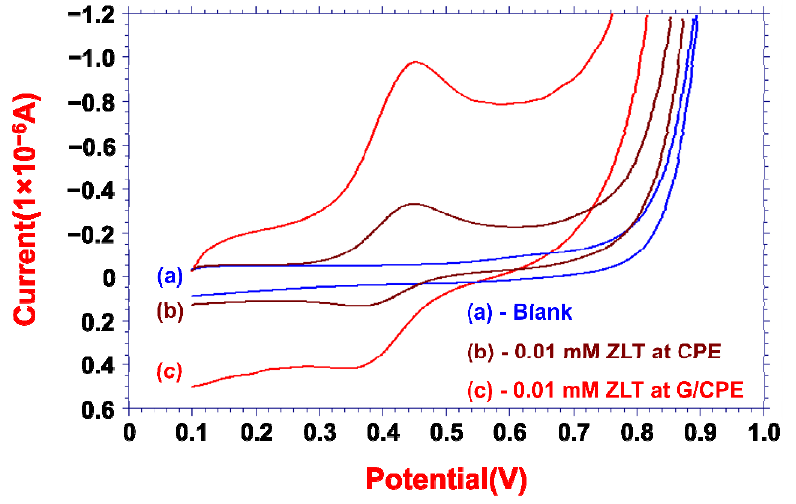
Figure 3. Cyclic voltammetric responses for 0.01 mM ZLT solution at CPE and G/CPE in PBS of pH 6.0.